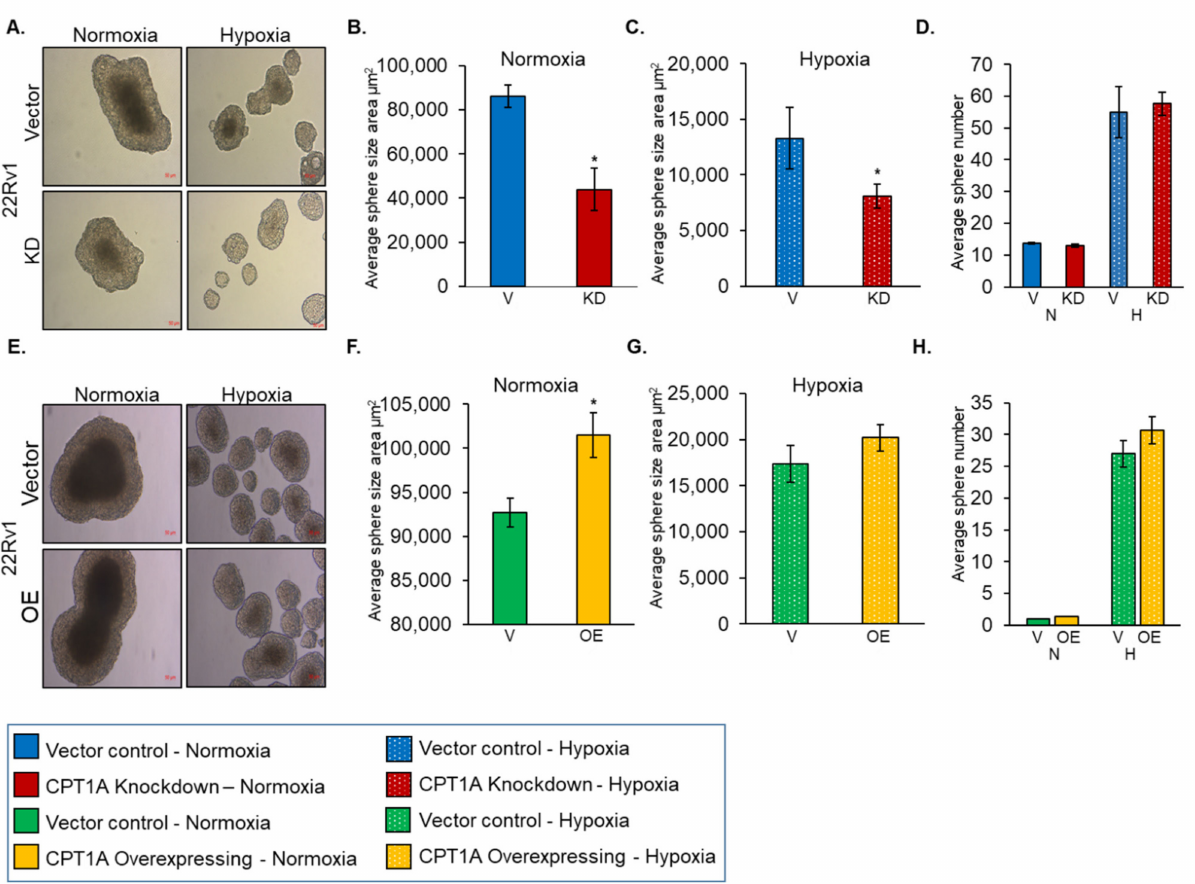
Figure 2. Role of CPT1A expression in 22Rv1 sphere formation. Sphere size and number were assessed in 22Rv1 with stable knockdown (KD, red) compared to vector control (V, blue) (* p < 0.001; n = 3, area calculated for n = 8 spheres) ( A – D ) or overexpression (OE, yellow) compared to vector control (V, green) (* p < 0.04; experiments performed in triplicate, area calculated for n = 5) ( E – H ) grown under normoxic (~21% O2, solid bars, N) or hypoxic (1% O2, dotted bars, H) conditions for 10 days. Images were captured under an inverted light microscope and representative images are shown at 20 × magnification. Data are representative of average ± SEM. Scale bar = 50 µ